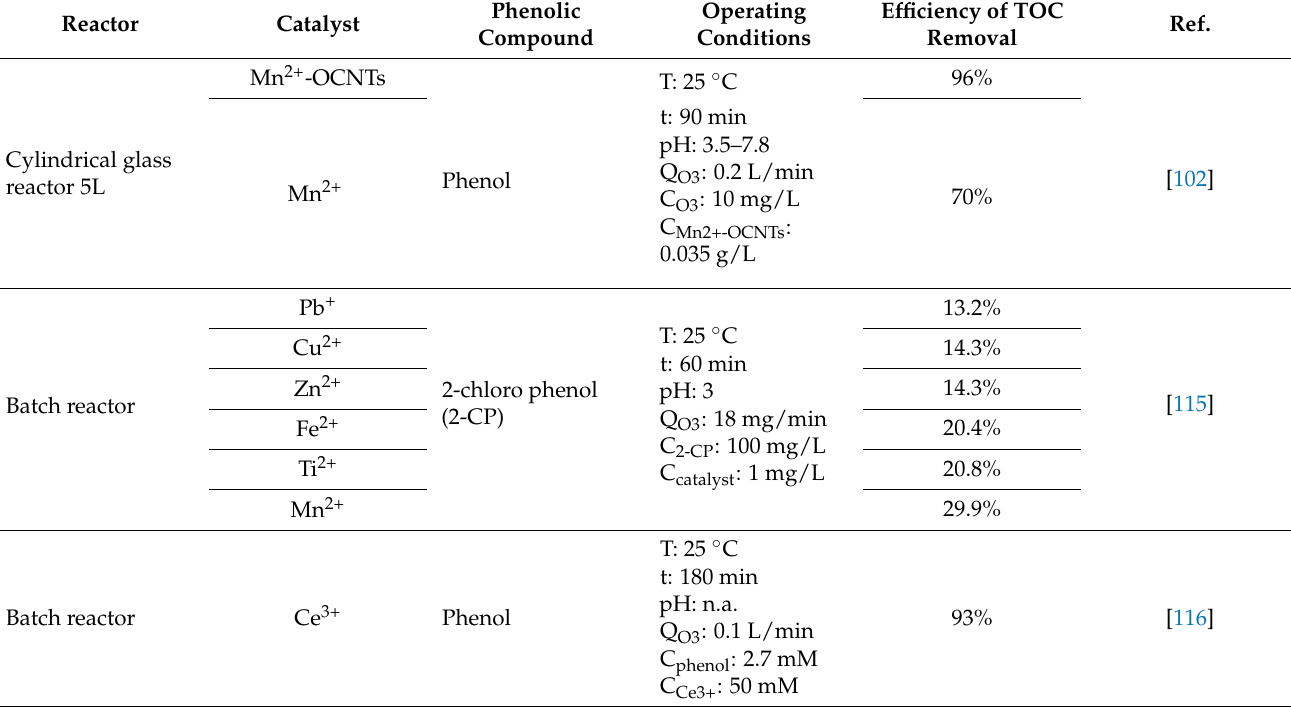
Table 12. Comparison of the efficiency of total organic carbon (TOC) removal using various homogeneous catalysts for phenolic compounds removal from aqueous solution through the catalytic ozonation